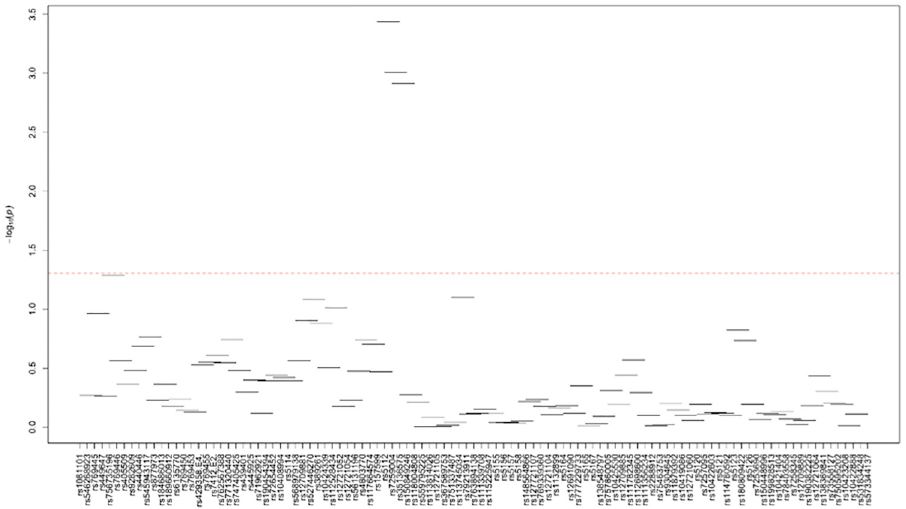
Fig 10. Plots of haplotype-based association analysis results for HDL-C in African blacks. Horizontal lines represent the 4-SNP windows. X-axis shows the SNPs genotyped in the regions based on the order of APOE , APOC1 , HCR1 , HCR2 , APOC4 and APOC2 while the Y-axis shows the–log (global p-value) with red line representing the p- value threshold (P =